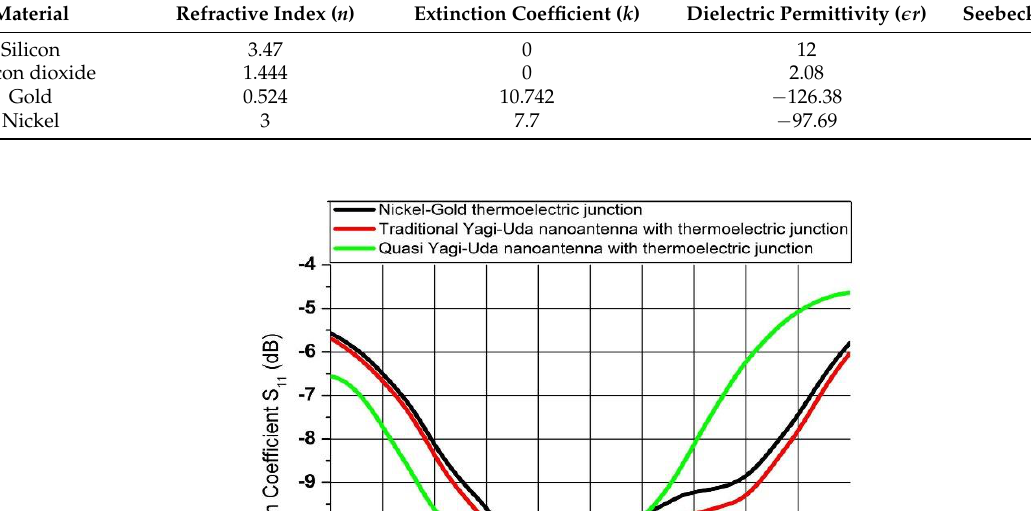
Table 1. Optical constants, dielectric permittivity, and Seebeck coefficients for materials at 193.5 THz [33,34]. Material